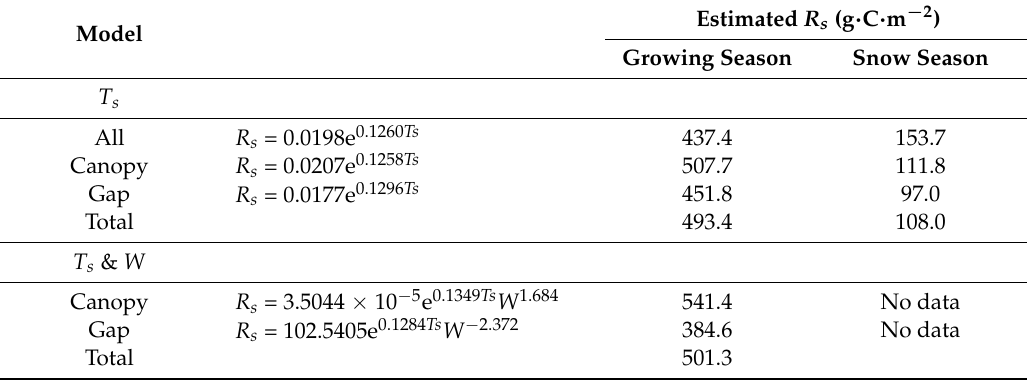
Table 3. Soil respiration ( R s ) estimated from the model using soil temperature ( T s ) and soil water content ( W ). R s during the growing season was estimated from 27 September to 27 October 2013 and from 4 June to 26 September 2014, and R s during the snow season was estimated from 28 October 2013 to 3 June 2014. Total R s was calculated from the R s values of the canopy and gap areas based on their relative sizes (canopy: 74.4%, gap: